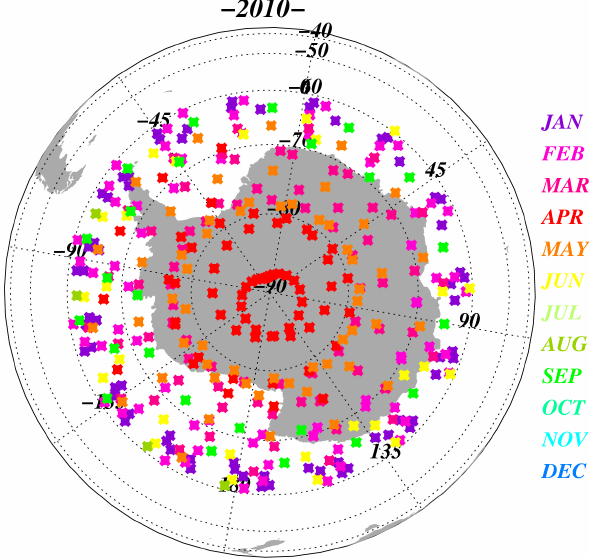
Fig. 1. SCIAMACHY lunar occultation tangent points in 2010; the latitudes vary within 59 ◦ S–89 ◦ S.